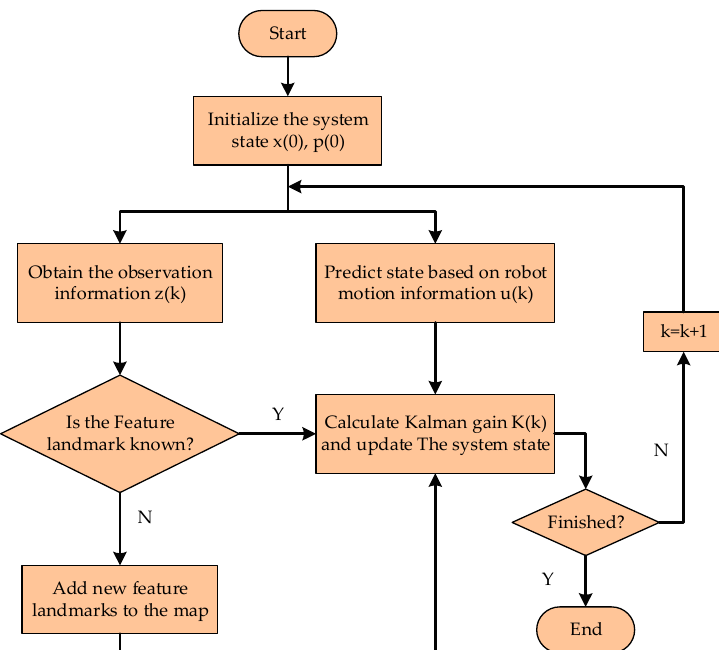
Figure 8. Extended Kalman filter (EKF)-SLAM processing flow chart.